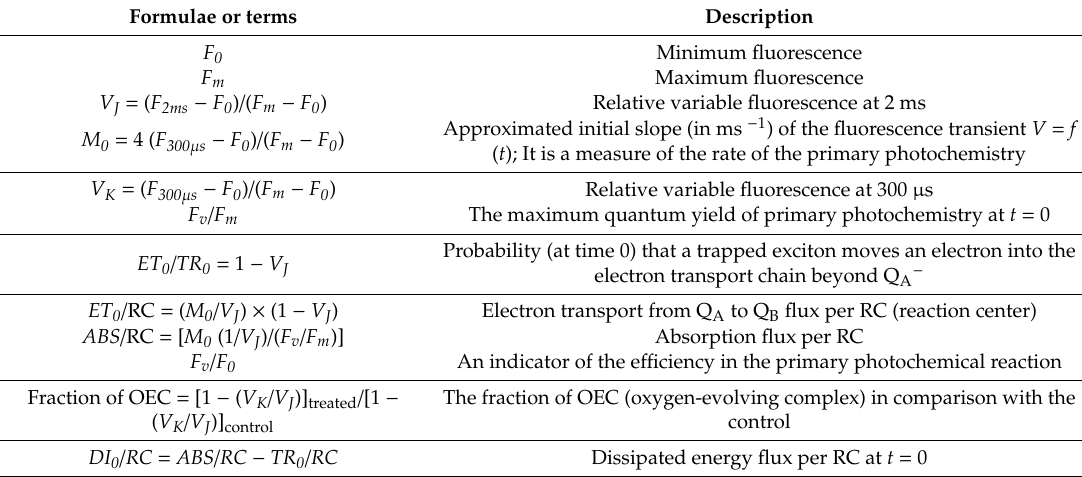
Table 1. Formulae or terms of the OJIP transient